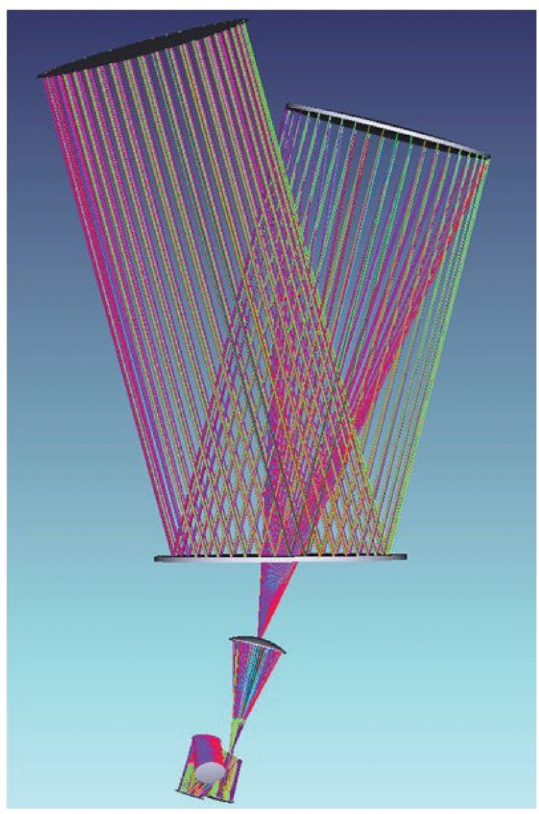
Figure 7: Schematic of FIREBall optical train. (1) A flat siderostat mirror, 1.3 m aperture, is followed by a 1-m